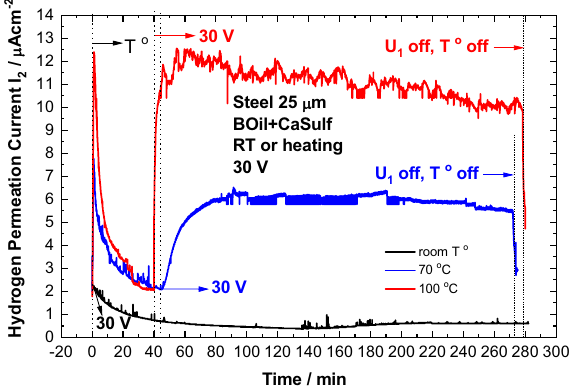
Figure 5. Hydrogen permeation transients recorded with BOil + CaSulf under voltage of 30 V at room temperature or upon heating at 70 °C or 100